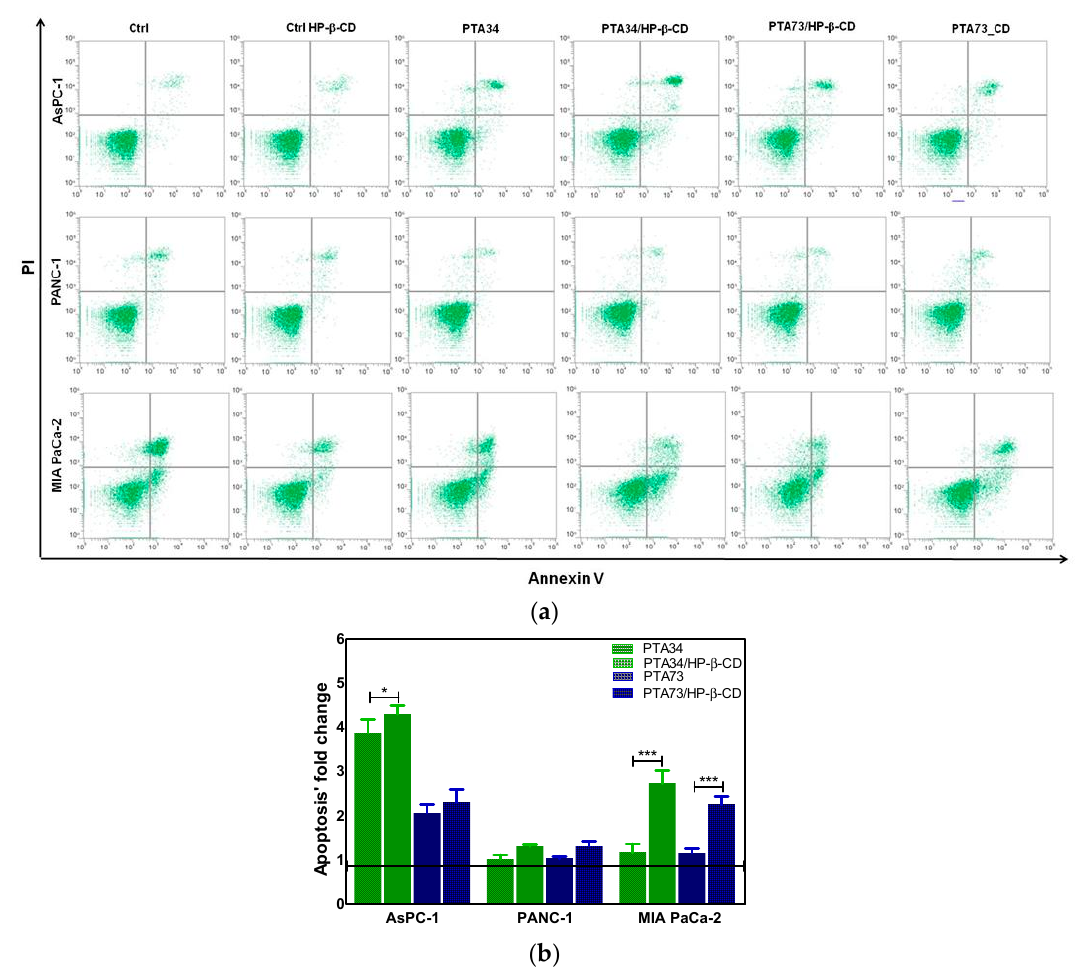
Figure 7. ( a ) Representative apoptosis analysis of PDAC cells after 24 h treatment with HP- β -CD alone (Ctrl HP- β -CD), PTA34, PTA34/HP- β -CD, PTA73, and PTA73/HP- β -CD. Apoptosis was evaluated by using Annexin V/PI staining followed by FCM analysis. ( b ) Fold change of Annexin V positive cells (early plus late apoptosis) in treated samples versus their corresponding reference compounds (Ctrl cells and Ctrl HP- β -CD for PTAs and complexed-PTAs treated cells, respectively). The results are the mean ± SD of three independent experiments (* p < 0.05; *** p < 0.001).